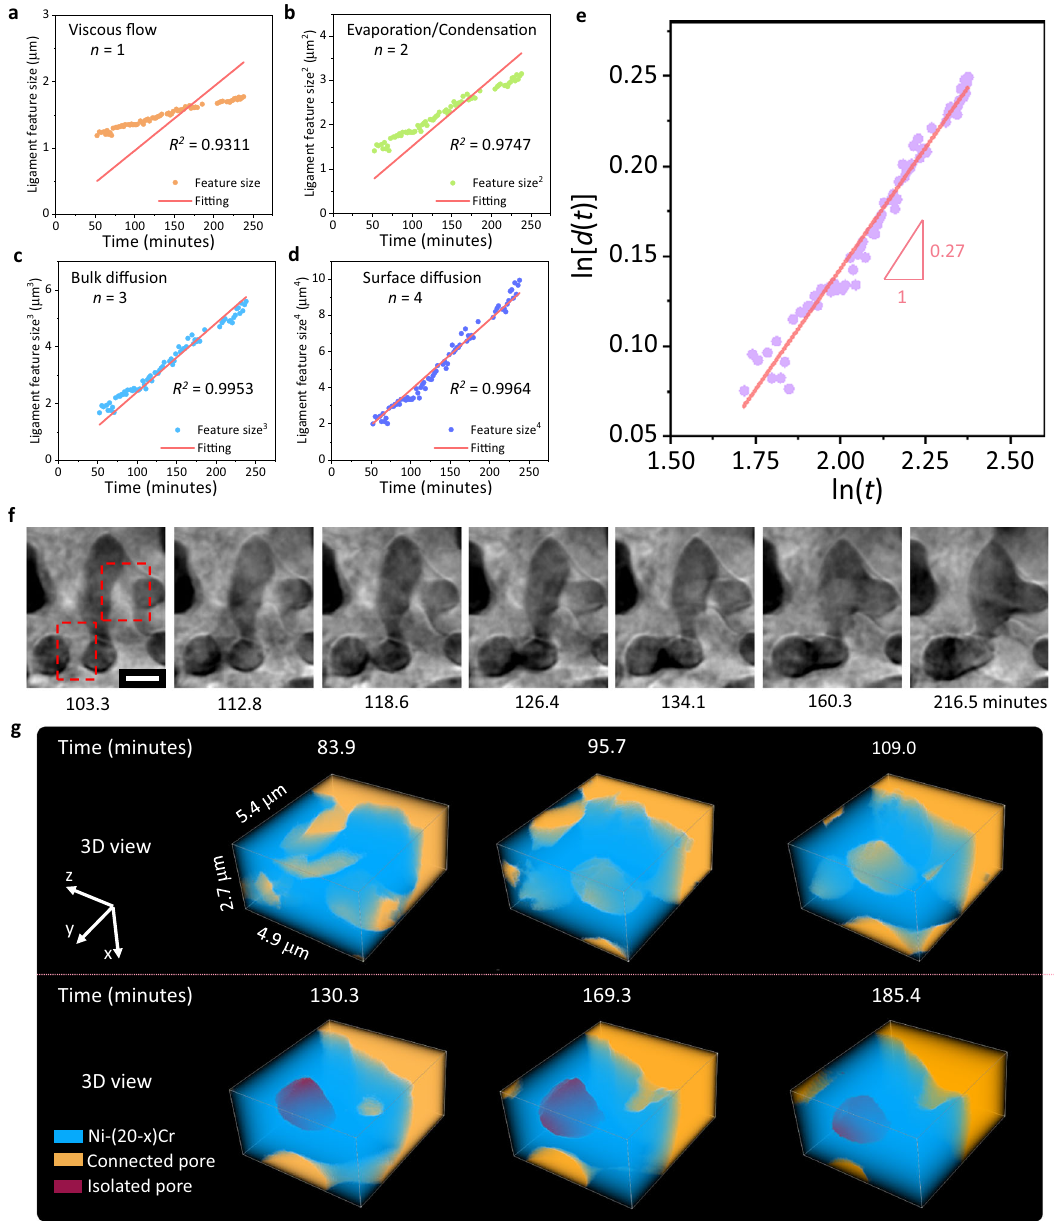
Fig. 5 Coarsening mechanism power-law fi tting for molten salt dealloying (MSD) and a direct observation of enclosed void formation. a – d Power-law linear fi tting ( n = 1 – 4) with goodness-of- fi t ( R 2 ) value of ligament feature size vs. coarsening time after the microwire has been fully dealloyed (~ 47 min during in situ heating), corresponding to different mechanisms: a viscous fl ow, b evaporation and condensation (here, Ni dissolution and redeposition), c bulk diffusion and d surface diffusion. e The plot of ln[ d ( t )] vs. ln(t) for measuring the coarsening exponents n = 1/0.27 = 3.7 close to 4 indicating that surface diffusion is the primary mechanism for coarsening in molten salt. f , g The morphology evolution during the coarsening process at the elevated temperature: f ligament pinch-off events; the scale bar is 2 μ m. g Development of an enclosed pore forming within the